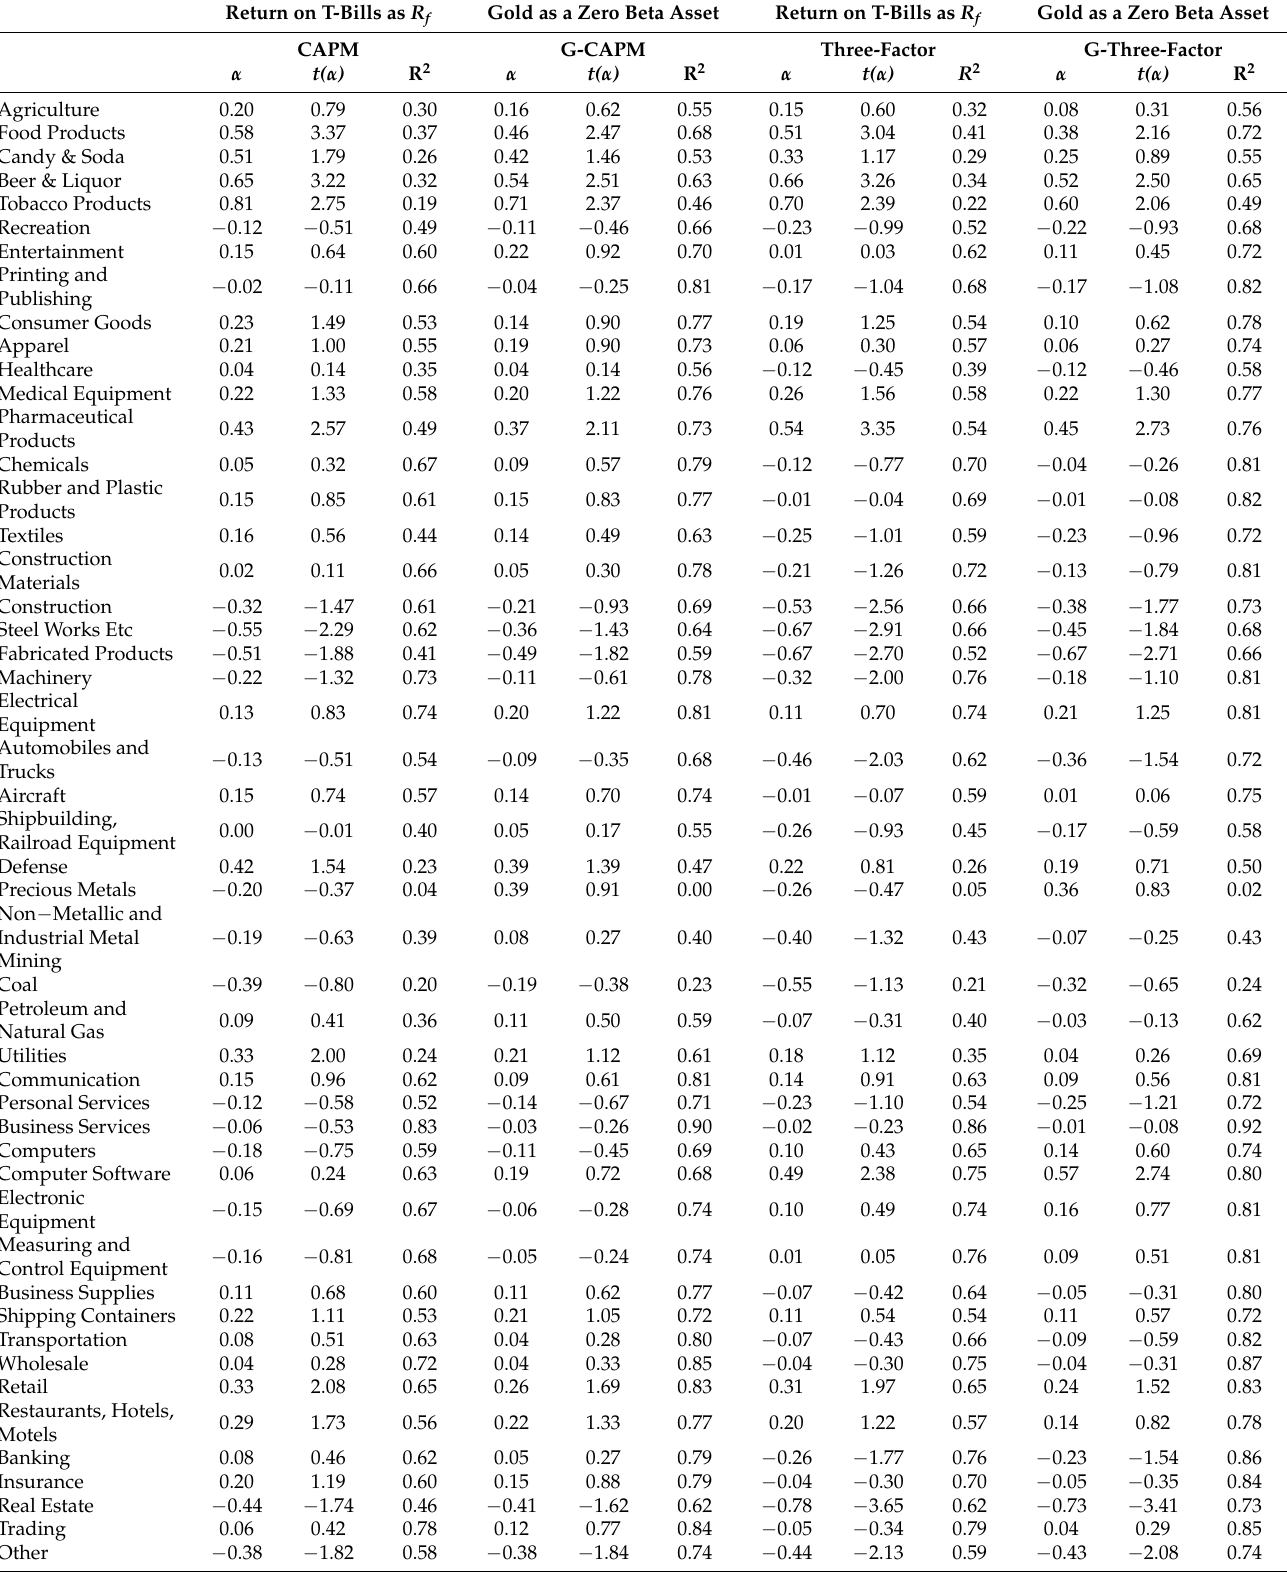
Table 4. Alphas from the CAPM, G-CAPM, three-factor, and G-three-factor regressions on 49 industry portfolios from January 1981 to December 2015. The table reports alphas ( α ), t-statistics t(a) , and adjusted R-squared of the tested